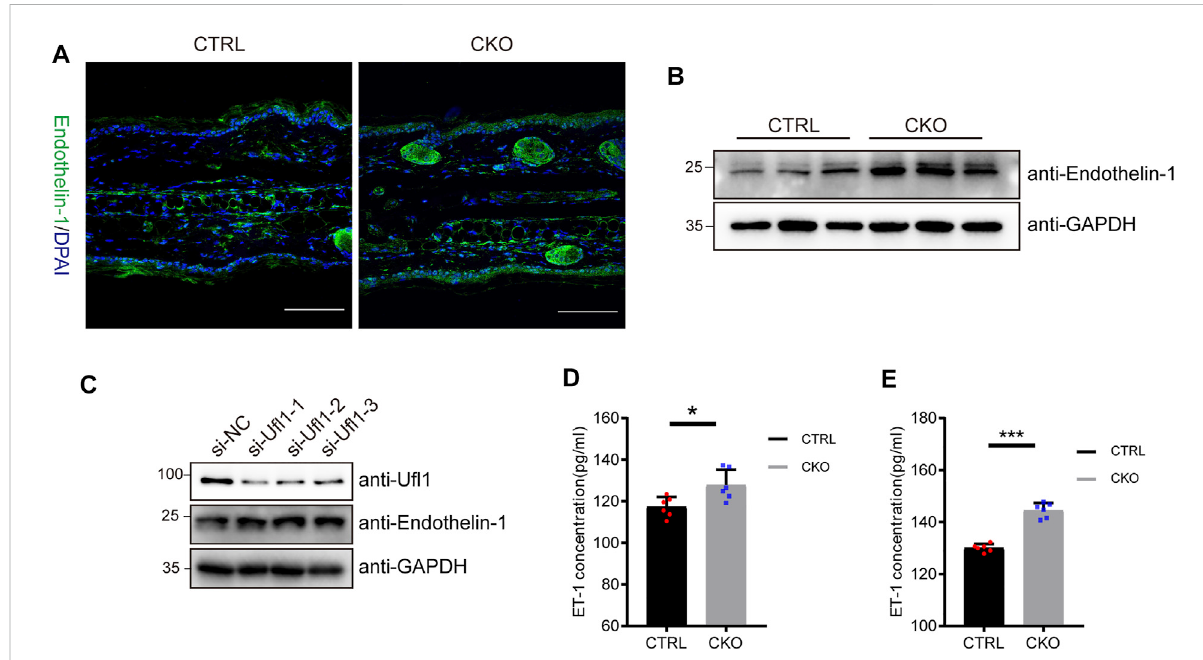
FIGURE 4 U fl 1 de fi ciency promote the expression and secretion of Endothelin-1 (ET-1). (A) Immuno fl uorescence staining for mice ears sections. The images showed ET-1 staining(green),and DAPIstaining(blue) as anuclearcounterstain (upperpanel). (B) Western blotanalysisofET-1 expression in theearsof3-month-oldCRTLandCKOmice( n =3). (C) WesternblotanalysisofET-1expressionintheHaCaTcellswith U fl 1 depletion.si-RNA,small interferingRNA;NC,negativecontrol. (D,E) ET-1secretionintheplasmaandearswasanalyzedbyELISA( n =6).* p < 0.05,*** p < 0.001,unpaired Student ’ s test. Error bars represent ± s.d. The scale bar represents 100 μ